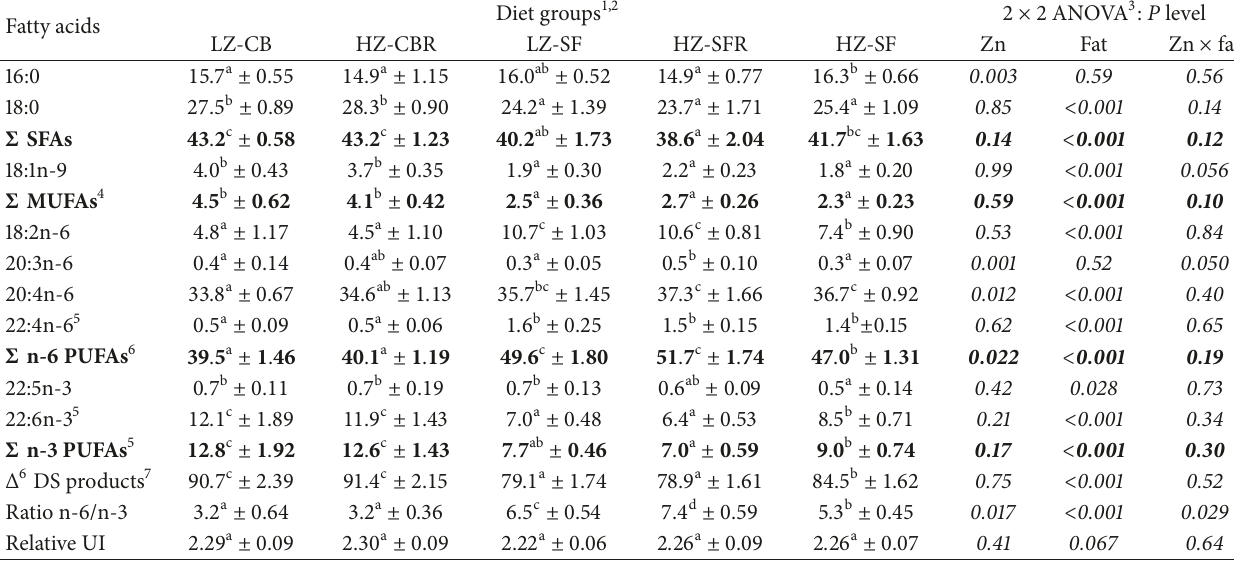
Table 4: Fatty acid composition (mol/100mol) of liver phospholipids in male weanling rats fed high-fat diets differing in Zn content and fat source free choice or in restricted amounts for 4